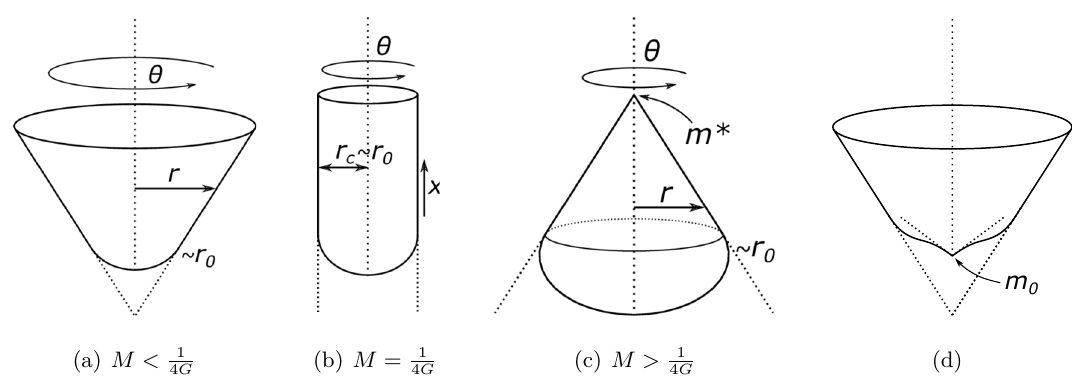
Figure 4 . Qualitative picture of the different spaces generated by self-gravitating Abrikosov